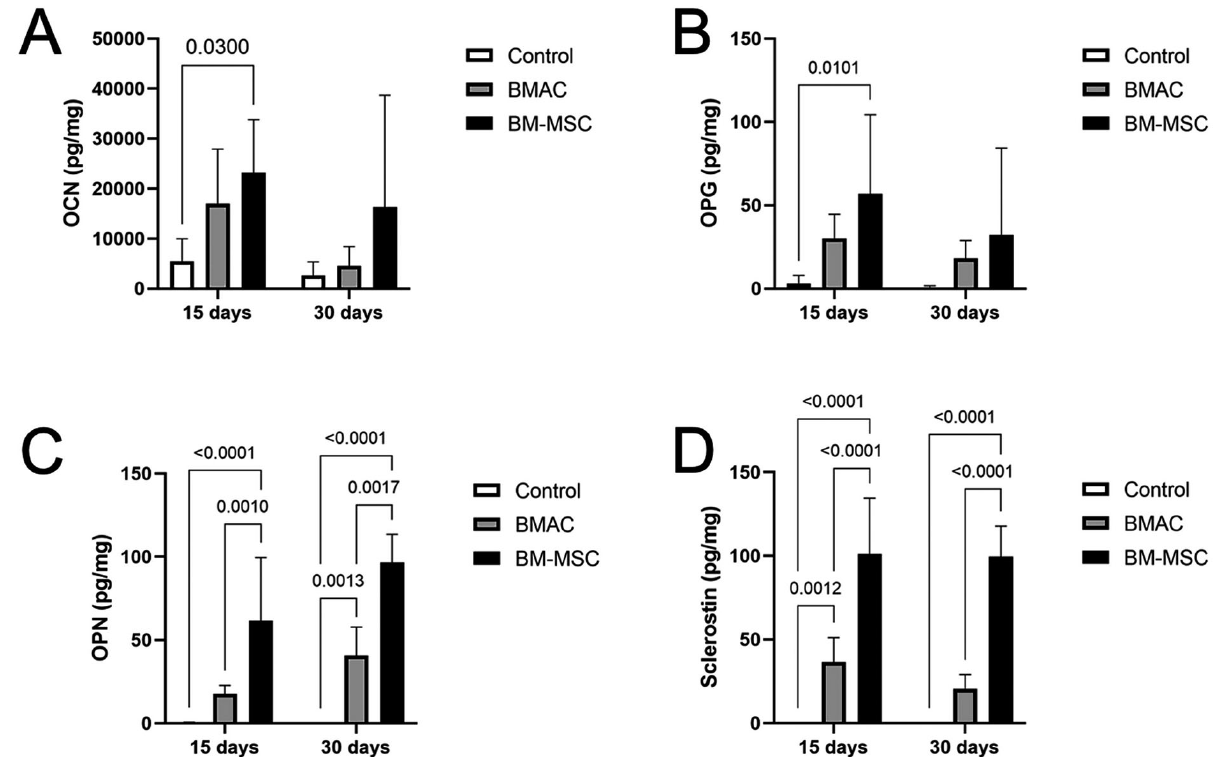
Figure 6- Cell phenotype investigation in Luminex assay within 15 and 30 days of spontaneous healing, and BMAC and BM-MSCs treatments. Histograms reporting (A) osteocalcin (OCN), (B) osteoprotegerin (OPG), (C) osteopontin (OPN), and (D) sclerostin